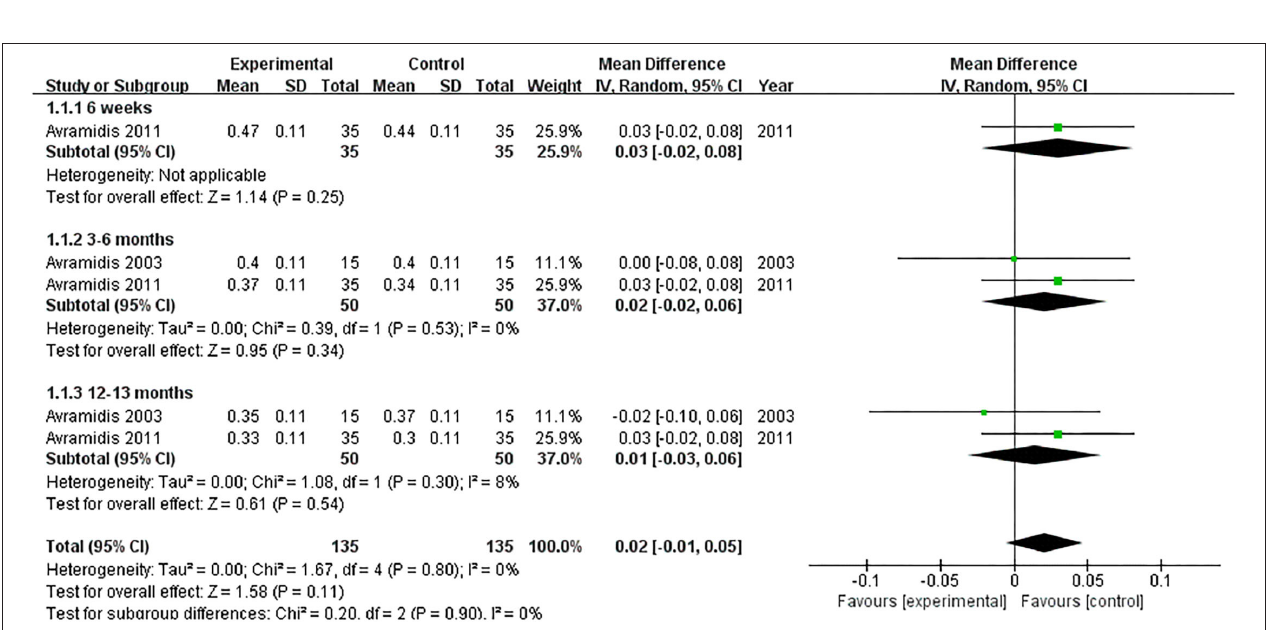
Frontiers in Medicine |